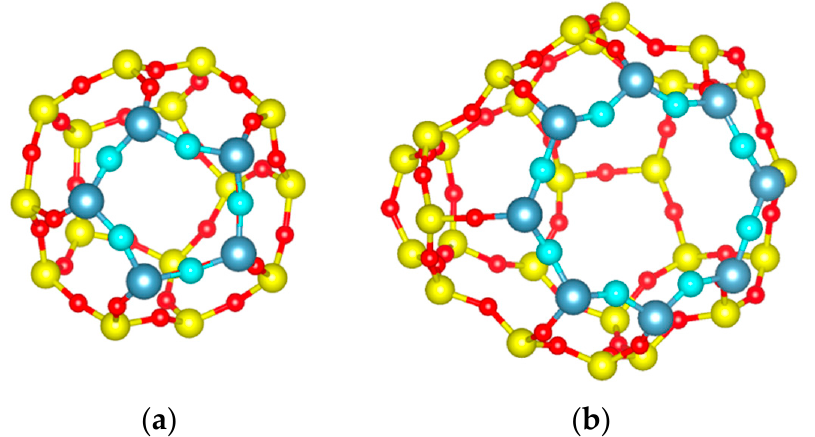
Figure 3. Visualization of the different cages of DD3R: ( a ) Visualization of DD3R sodalite cage. Aperture atoms are in different colors for visualization purposes (oxygen is cyan and silicon is silver); ( b ) Visualization of the DD3R alpha cage, showing the 8-member ring opening with the smallest interatomic distance between two opposing oxygens of (3.6 Å).